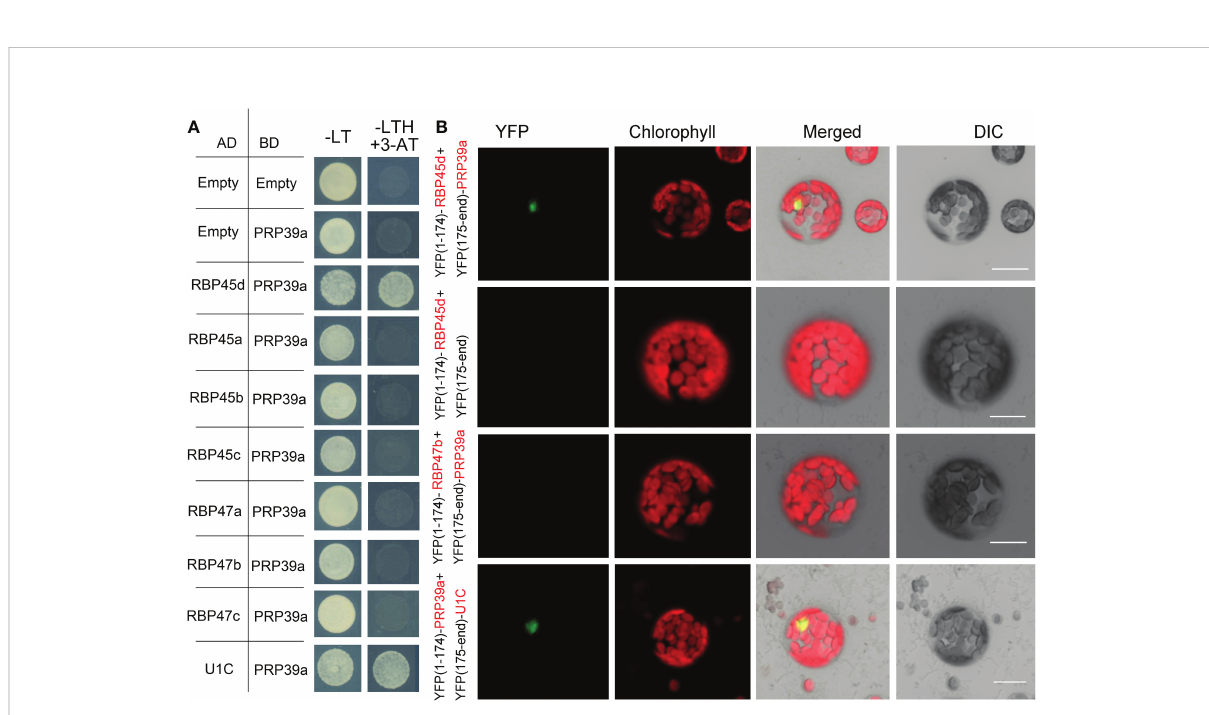
FIGURE 9 PRP39a interacts with RBP45d and U1C. (A) Yeast two-hybrid assays of the interaction between PRP39a and RBP45/47 members or U1C. The transformed yeast cells were grown on -LT (SD-Leu/-Trp) mediums and -LTH+3-AT (SD- Leu/-Trp/-His with 5 mM 3-AT) mediums. (B) BiFC assay of the interaction between PRP39a and RBP45d, RBP47b or U1C. YFP, fl uorescence of yellow fl uorescent protein; DIC, Differential interference contrast microscopy; Merge, merge of YFP, DIC and chlorophyll. Bar = 15 m